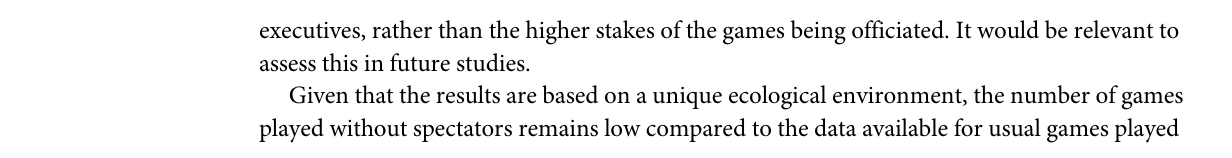
Fig 3. Mean penalty kills per team with and without attendance during the CHL regular season. For the sake of simplicity, the raw data have been presented in the figure, even though the model results in Tables 5 and 6 are in log-odds.